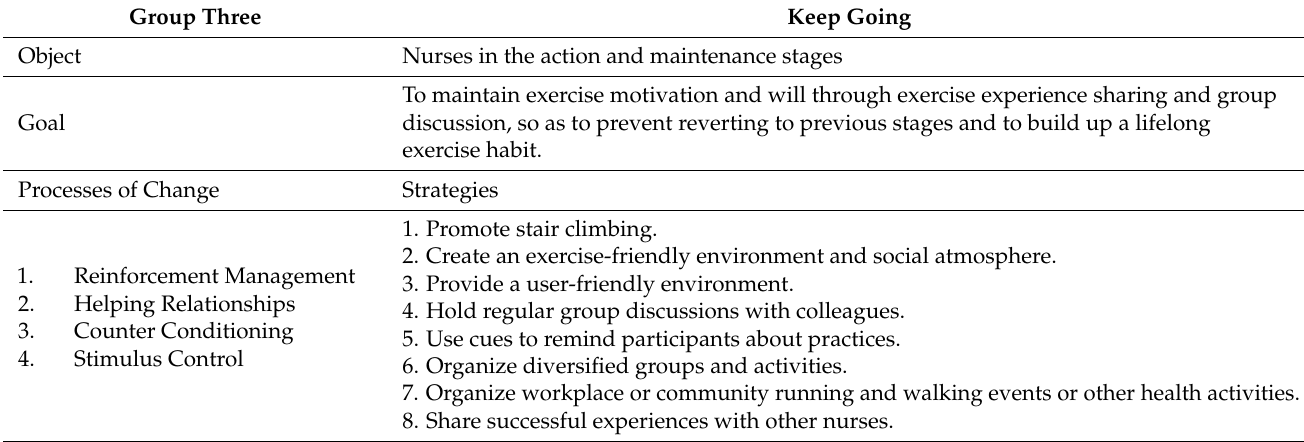
Table 3. Teaching strategies for group three—“Keep